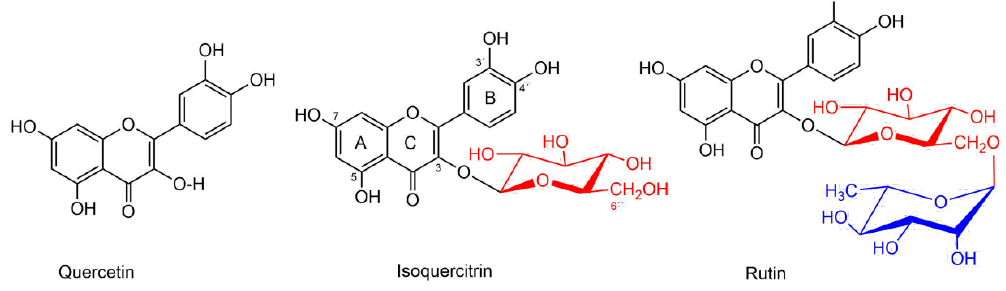
Figure 1. Chemical structures of quercetin and its glycosides isoquercitrin and rutin. The differences are shown in color and consist of the attached sugar moiety at C-3 of quercetin: rutinose ( L -α rhamnopyranosyl(1-6)β- D -glucopyranose) in the case of rutin, while β- D -glucopyranose in the case of isoquercitrin.